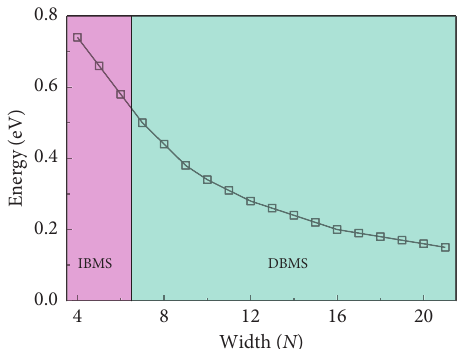
Figure 4: Change in the bandgap energy in terms of the width of the N-ZKGNRs ( N � 4–21). The IBMS and DBMS represent indirect-gap bipolar magnetic semiconductor and direct-gap bipolar magnetic semiconductor, respectively.